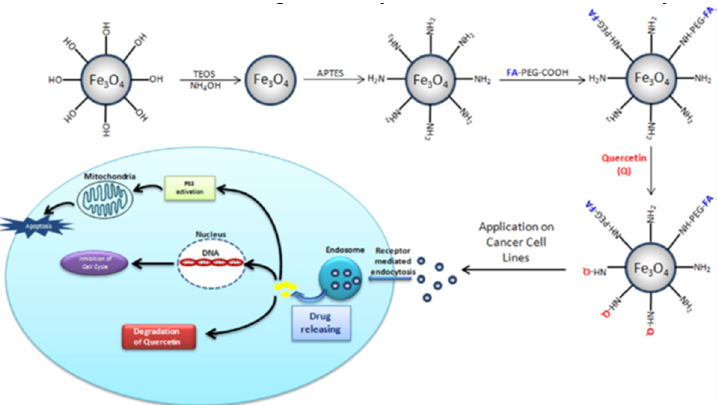
Figure 6. Schematic illustration of synthesis of superparamagnetic iron oxide nanoparticles (SPION) functionalized with (3-Aminopropyl)triethoxysilane (APTES), after which carboxylated polyethylene glycol (PEG-COOH), folic acid (FA) and carboxylate quercetin (CQ) were conjugated on the surface via a carboxylic / amine group using the nanoprecipitation method (designated SPION@APTES@FA PEG@CQ) and its e ff ect mechanism on cells (in a study of Alpsoy et al. [46], CQ was replaced by usnic acid). Reprinted from Ceramics International, 42, Akal, Z.U.; Alpsoy, L.; Baykal, A., Heparin appended Copyright (2016), with permission from Elsevier.